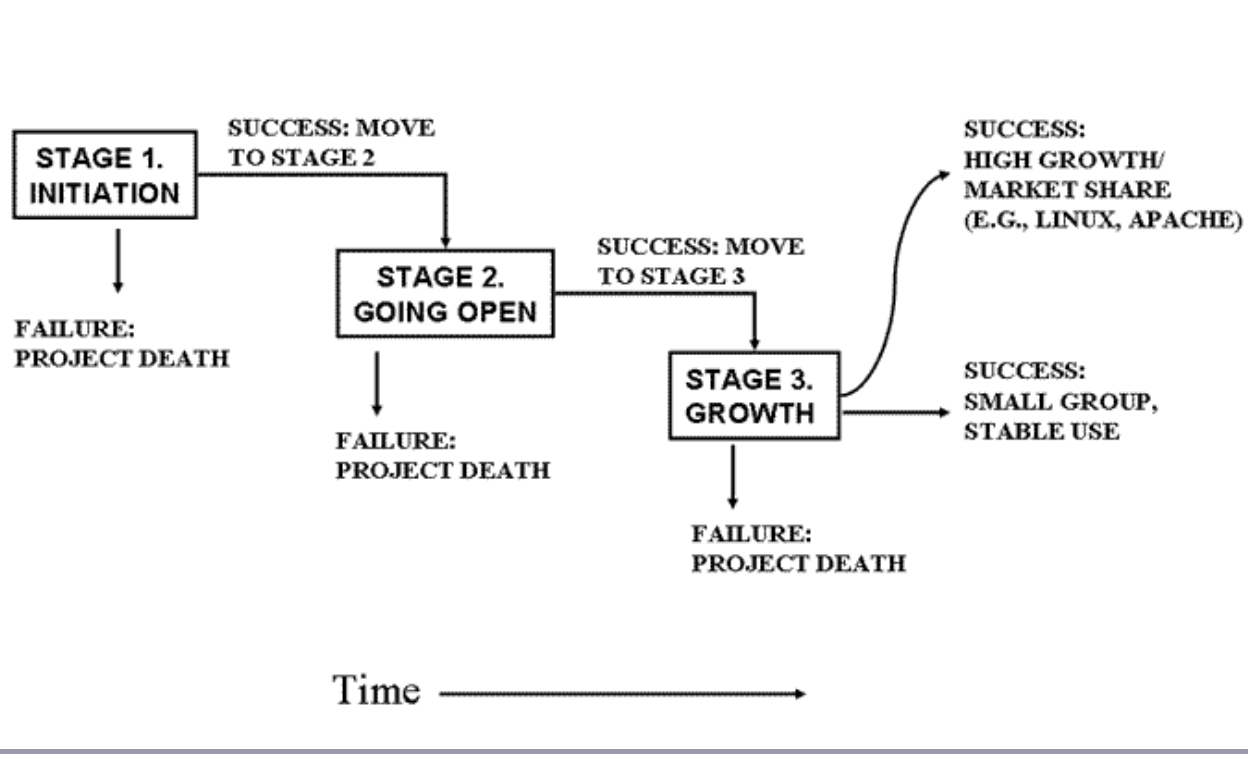
Fig. 1. The trajectory of free/libre or open source software projects (adapted from Schweik and Semenov 2003). Open content projects may follow a similar